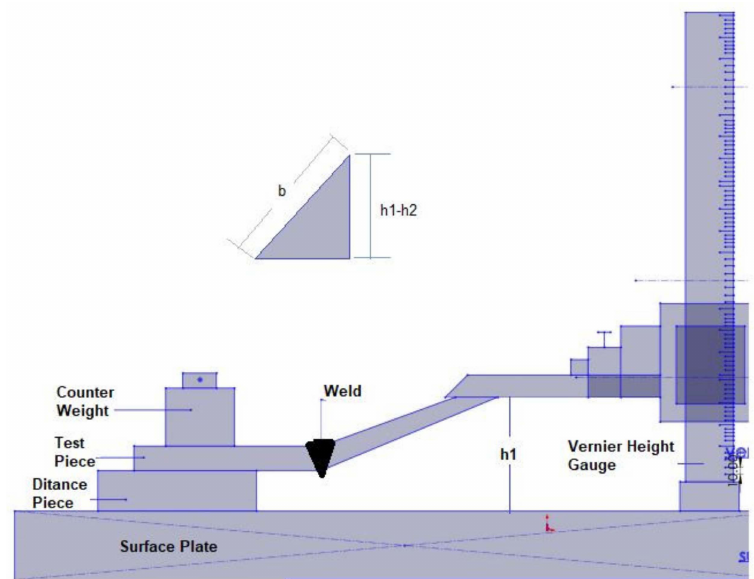
Figure 4. SINE BAR arrangement for measuring angular